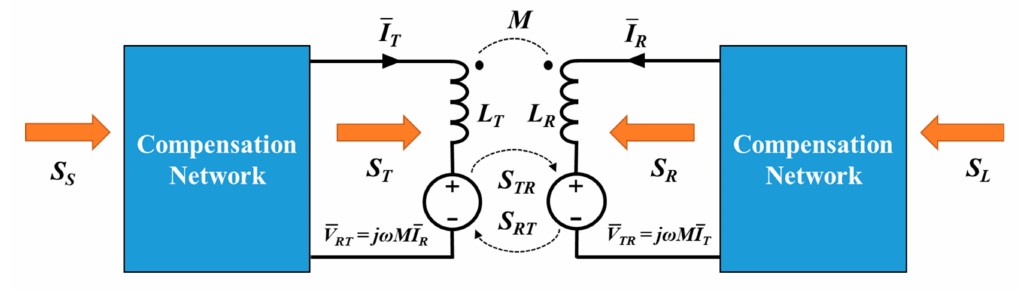
Figure 2. General schematic diagram of the inductively coupled WPT